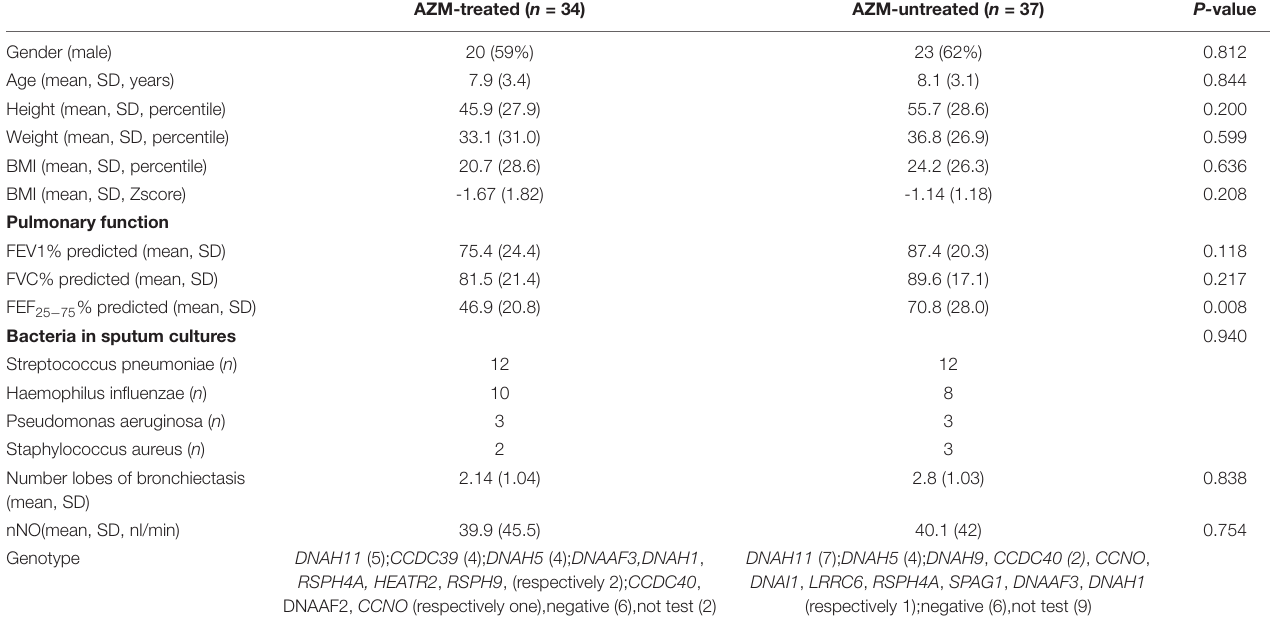
TABLE 1 | Baseline characteristics of patients by treatment